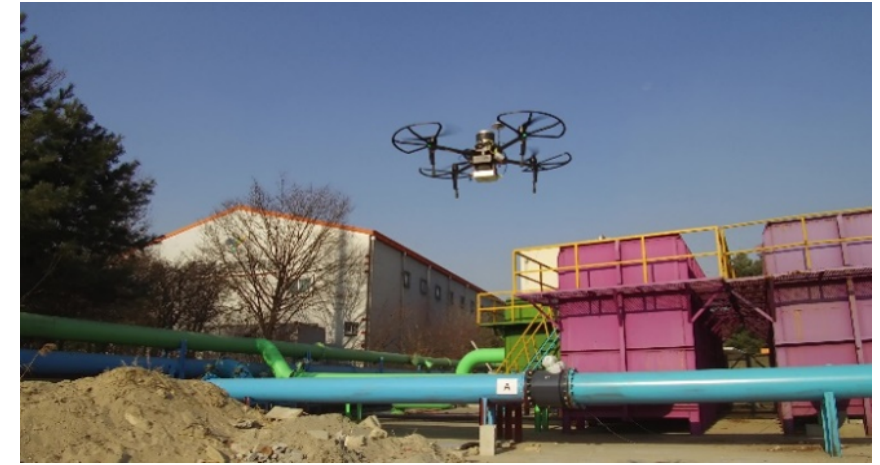
Figure 5. UAV on-site for the partial PCD acquisition using Velodyne Puck